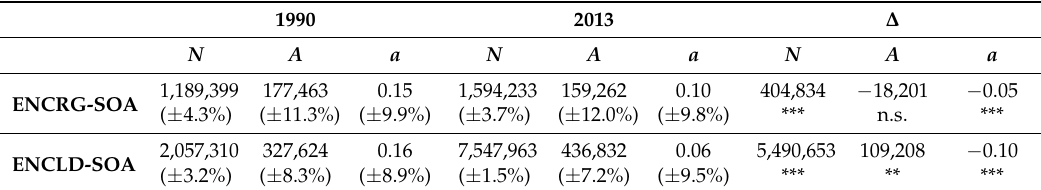
Table 2. Number ( N ), coverage ( A , in ha) and average size ( a , in ha) of SOA (encld-SOA and encrg-SOA) at 1990 and 2013 ( ± their estimated relative standard errors, in percentage). Significance levels (not significant for p value > 0.1, significant for p value ≤ 0.1, very significant for p value ≤ 0.05 and extremely significant for p value ≤ 0.01) of changes between 1990 and 2013 ( ∆ ) are also reported in the summary tables with the relative symbol (n.s., *, **, ***, respectively). 1990